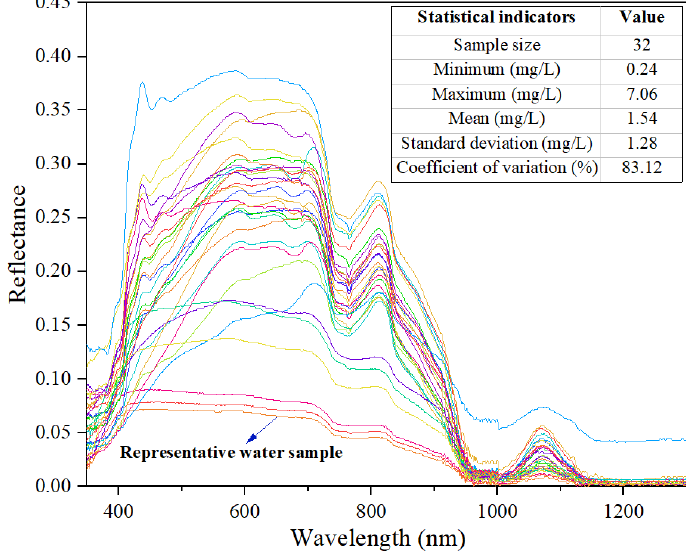
Figure 2. Spectrum curve of water samples and variation of the nitrogen concentration.